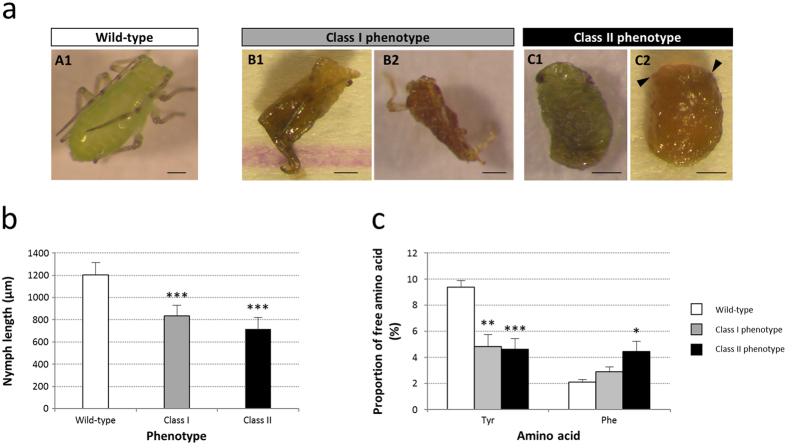
Nymph phenotypes induced by parental ApPAH RNAi.(a) Morphological alteration of defective nymphs laid by dsApPAH-injected aphids. Two nymph classes were distinguished based on the apparent severity of their morphological phenotypes, compared to the wild type (A1). B1-B2: Class I “moderate” phenotype. Note the abnormal body shape and the deformed or vestigial thoracic legs. C1-C2: Class II “severe” phenotype. Note the defective development of nymph appendages, including antennae, labium and thoracic legs, and eye abnormalities. Arrowheads indicate missing or underdeveloped eye structures. Scale bars = 200 μm. (b) Variation in nymph length in relation to phenotypes. Results are reported as means ± SD, n > 10 nymphs per phenotype. Data were analyzed by one-way ANOVA followed by a post hoc multiple comparisons test (Tukey’s HSD test). Significant differences, compared to wild type, are indicated with asterisks (***P < 0.001). (c) Single nymph HPLC analyses of free tyrosine and phenylalanine. Results are expressed as a percentage of the total amount of amino acids in the different phenotypes and reported as means ± SD, n = 8 nymphs per phenotype. Data were analyzed by one-way ANOVA followed by a post hoc multiple comparisons test (Tukey’s HSD test). Significant differences, compared to the wild type, are indicated with asterisks (*P < 0.05; **P < 0.01; ***P < 0.001).